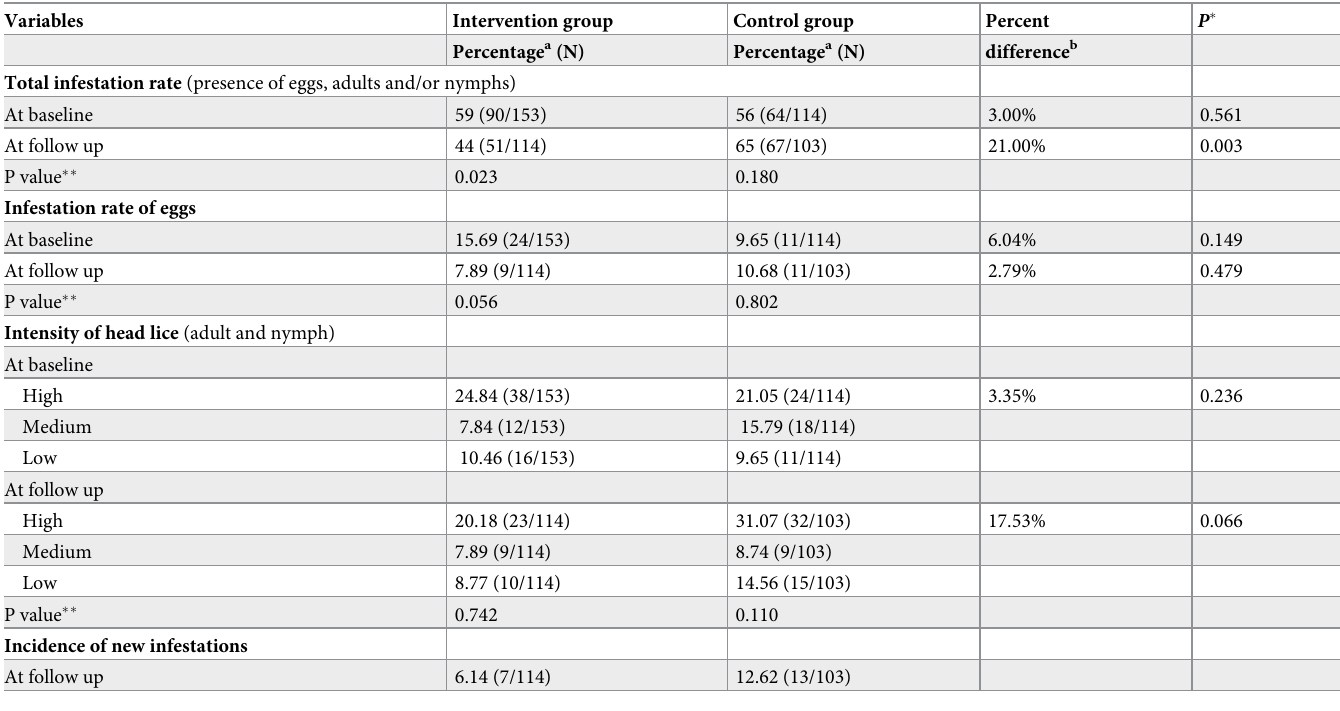
Table 2. The rate of head lice infestation, incidence and intensity in intervention and control groups at baseline and the two-month follow-up